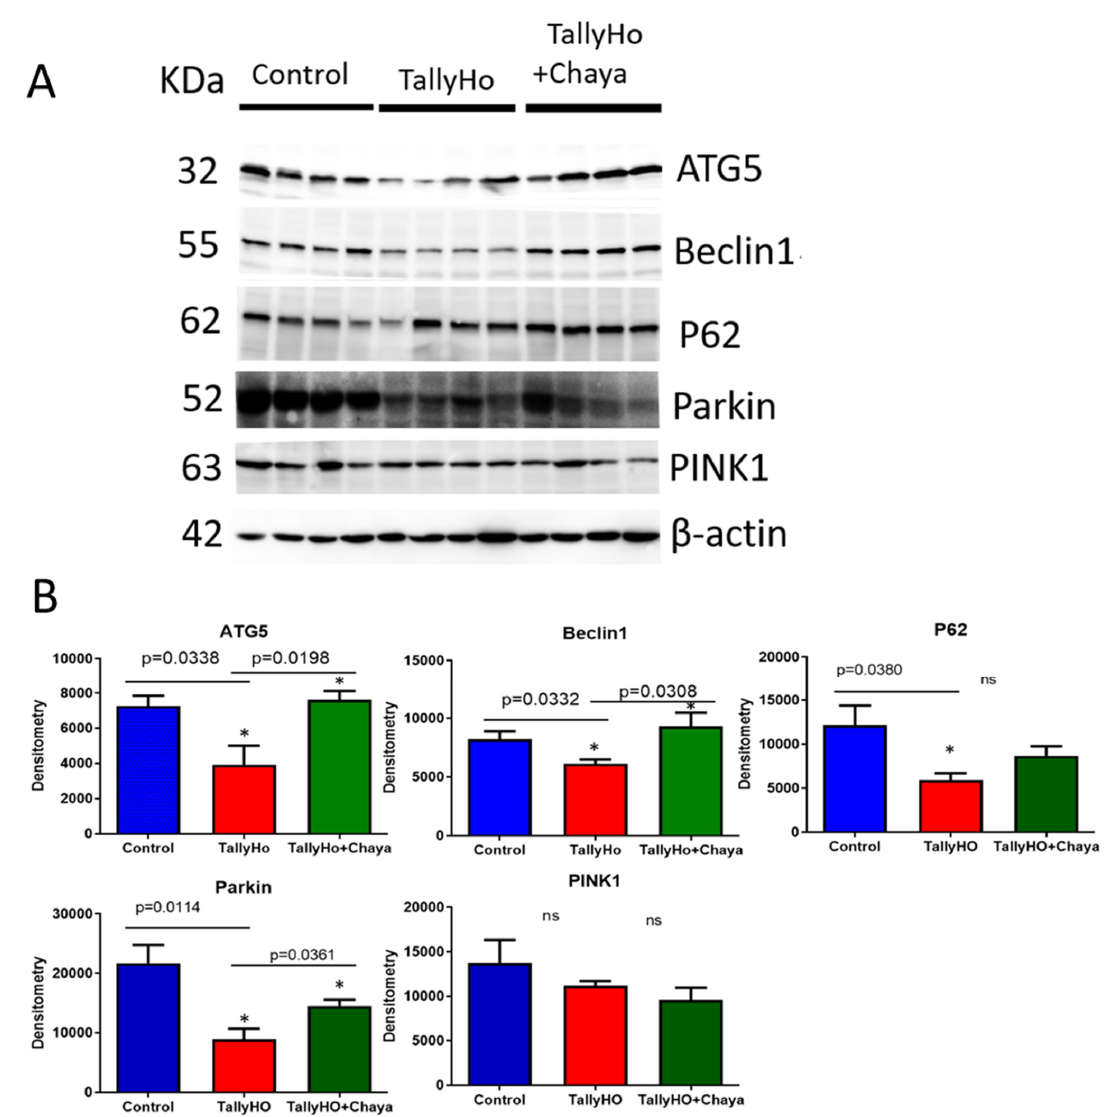
Figure 5. Immunoblotting analysis of autophagy and mitophagy proteins using protein lysates obtained from the post-mortem brains of 14-month-old non-diabetic control mice, TH mice fed with chaya, and TH mice fed with regular chow (for each of the three groups, n = 4). ( A ) Immunoblots for the control, TH, and TH + chaya mice. ( B ) Quantitative densitometry analysis for the autophagy and mitophagy proteins ATG5, Beclin1, P62, and Parkin, which were significantly decreased in the TH mice compared to the control mice (ATG5, p = 0.0338; Beclin1, p = 0.0332; P62, p = 0.0380; and Parkin, p = 0.0114). The ATG5, Beclin1, and Parkin levels were significantly increased in the TH + chaya mice at levels comparable to the control mice (ATG5, p = 0.0198; Beclin1, p = 0.0308; and Parkin, p = 0.0361). The levels of P62 in the TH + chaya mice showed an increasing trend, but the levels did not show statistical significance. PINK1 did not show any statistical significance between the TH mice and the control mice. * p =